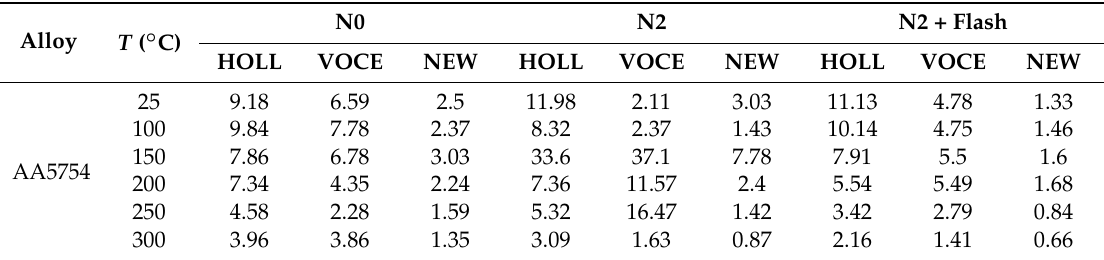
Table 13. RMSE of each flow rule obtained for AA5754 in relation to the experimental curve (MPa). Alloy